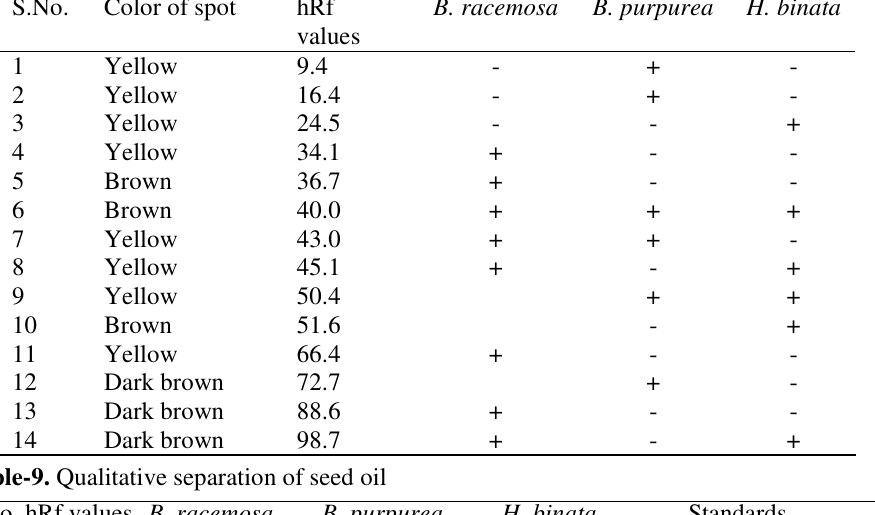
Table-9. Qualitative separation of seed oil S.No. hRf values B.